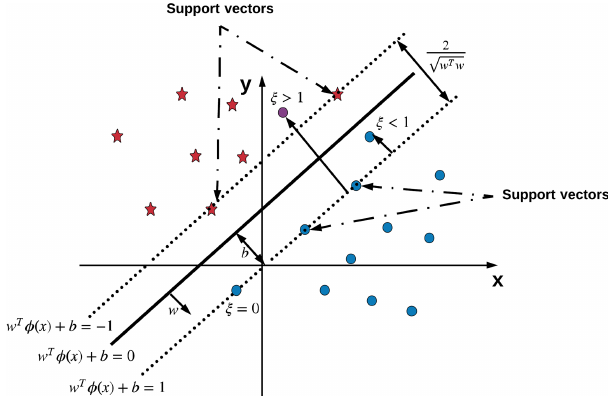
Figure 7. An example of linear SVM that finds the optimal hy- perplane w T φ(x) + b = 0, its maximum-margin 2 √ separating w T w samples from two classes in data (blue dots and red stars), and all other quantities in Eqs. (3)–(4). ζ is a variable defining how much on the “wrong” side of the hyperplane a sample is: if it is 1 > ζ > 0, the point is classified correctly but by less of a margin than the op- timal hyperplane was found; otherwise, if it is more than ζ > 1, the point is classified incorrectly. The magenta dot indicates an exam- ple of the misclassified sample from the class of blue dots. Support vectors help to find the margin for the optimal linear hyperplane. φ(x) is a linear transformation in this